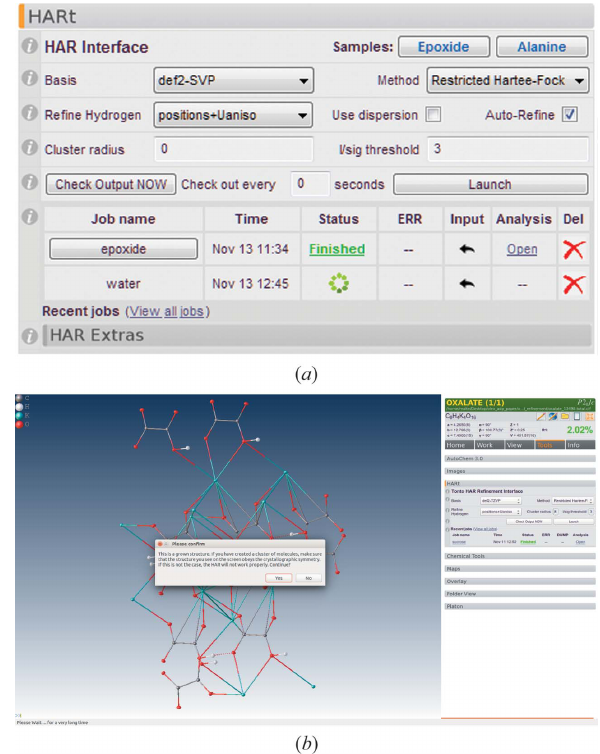
Figure 1 The HARt – Olex2 interface. ( a ) The HARt panel in the Olex2 software, as of 13 November 2017. ( b ) A screenshot of the Olex2 software, showing the cluster of KHOx used for HAR and a pop-up window asking the user to confirm before starting the